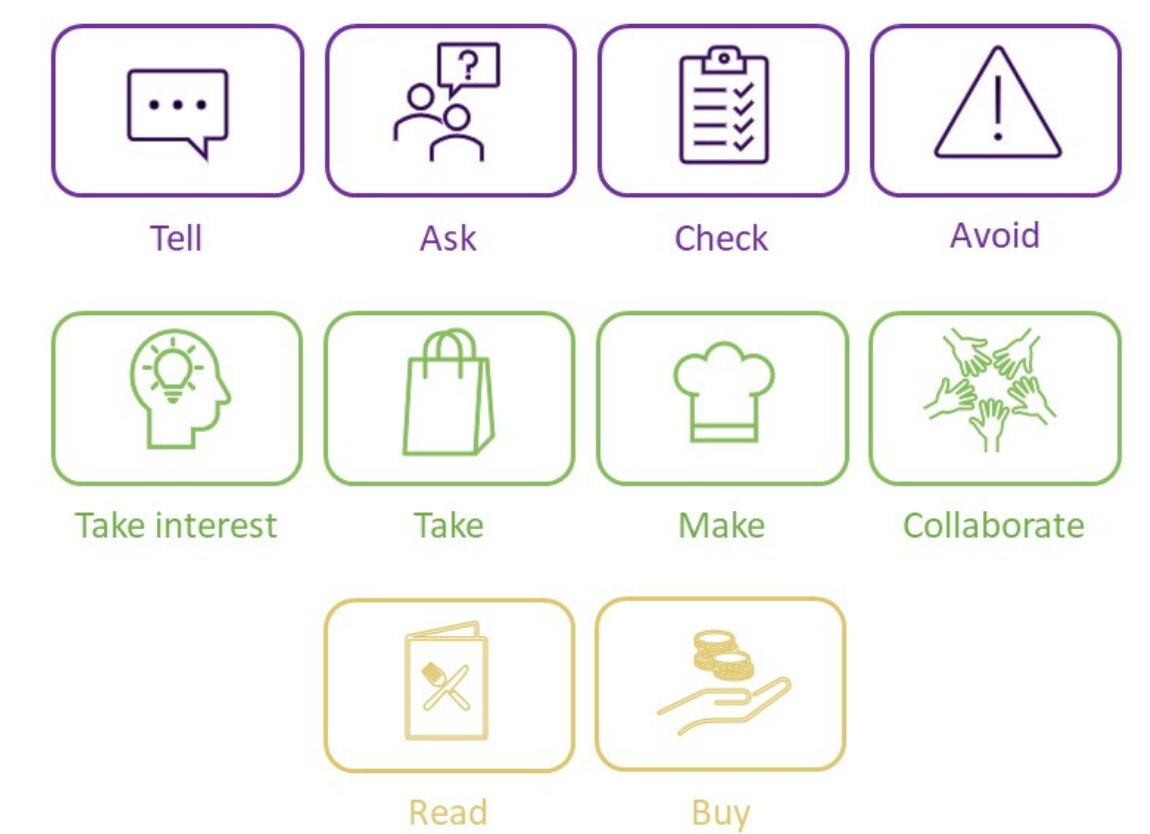
Figure 2. Managing celiac disease: do and don’t actions.